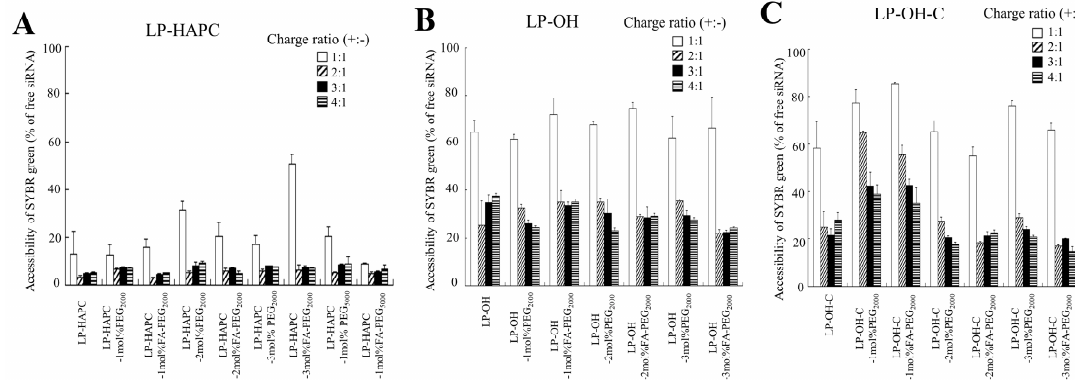
Figure 6. E ff ect of FA-PEG-modification of cationic liposomes on association of siRNA with FA-PEG-modified cationic liposome. siRNA association by cationic liposomes was analyzed by exclusion assay using an SYBR ® Green I Nucleic Acid Gel Stain. ( A ) LP-HAPC-1–3mol%PEG 2000 ,